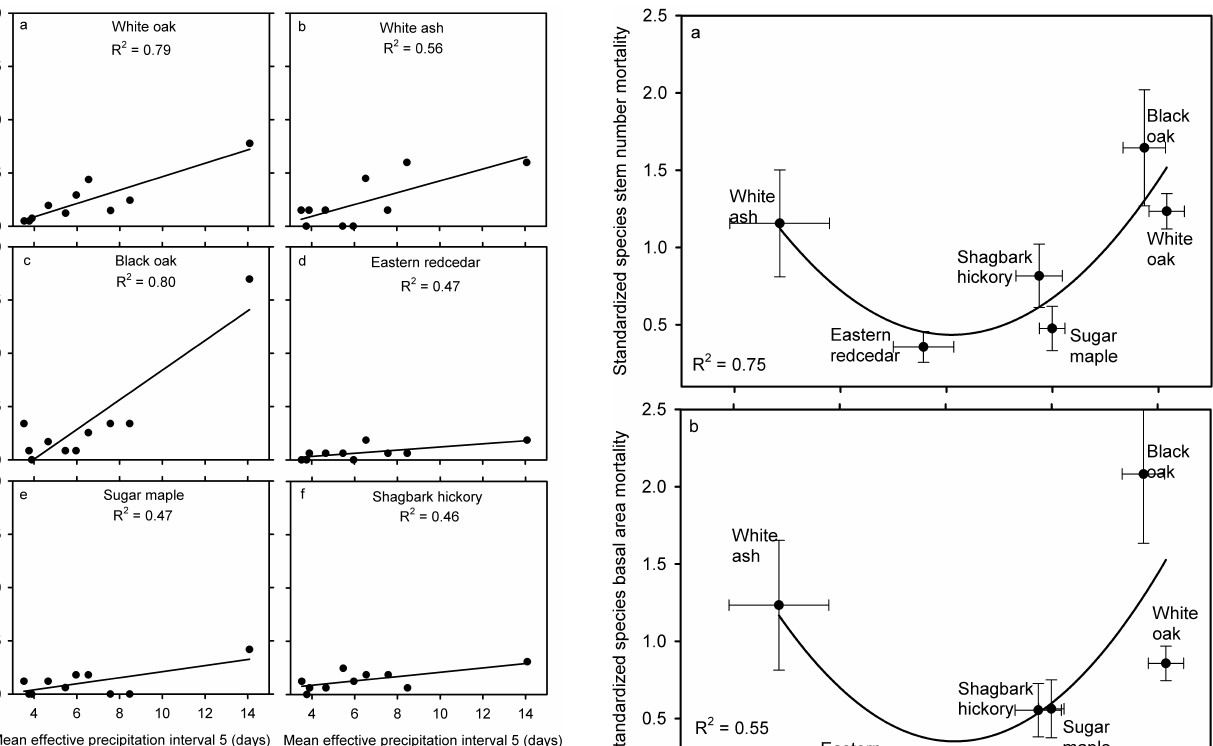
Figure 10. The species mortality expressed relative to the stem number density of 2005 as a function of the mean effective precipitation integral with a threshold daily precipitation rate of 5mmday − 1 (MEPI5) in the previous year. Fittings are linear.